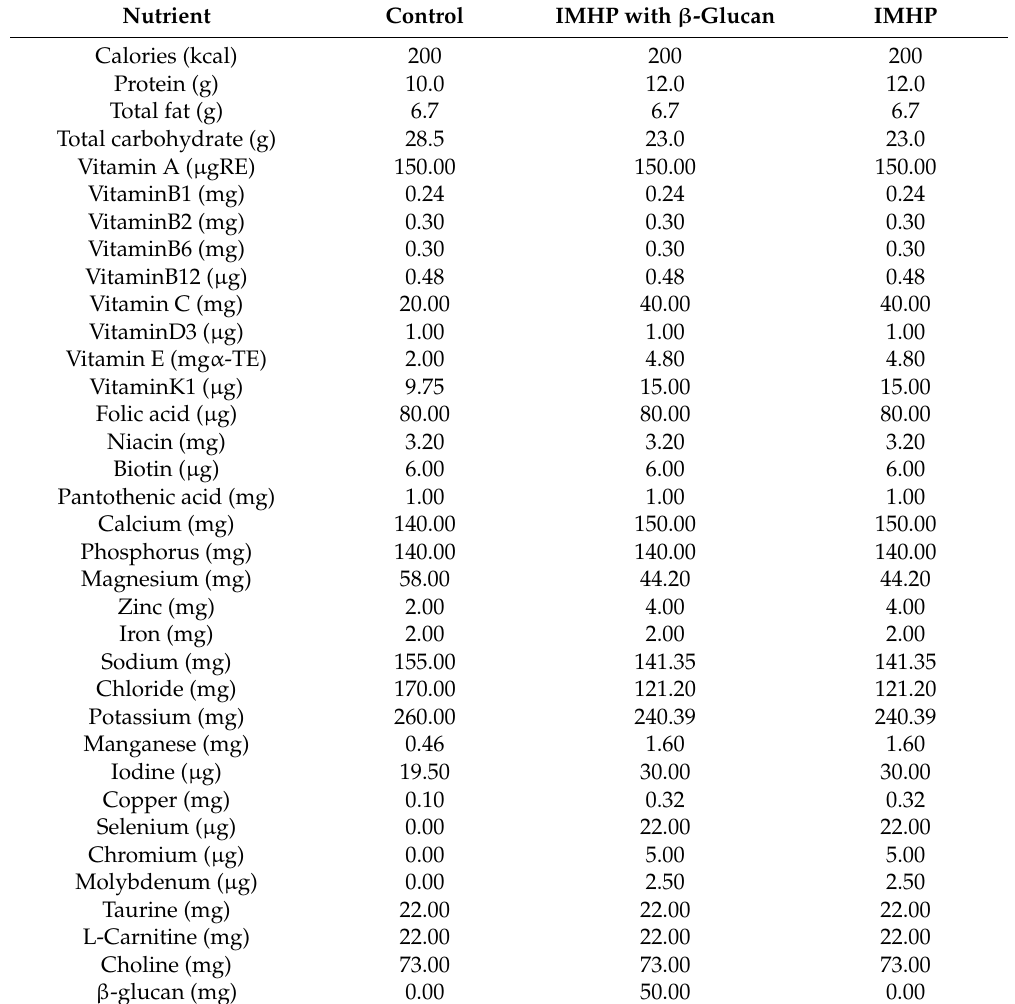
Table 1. Composition of the enteral nutrition